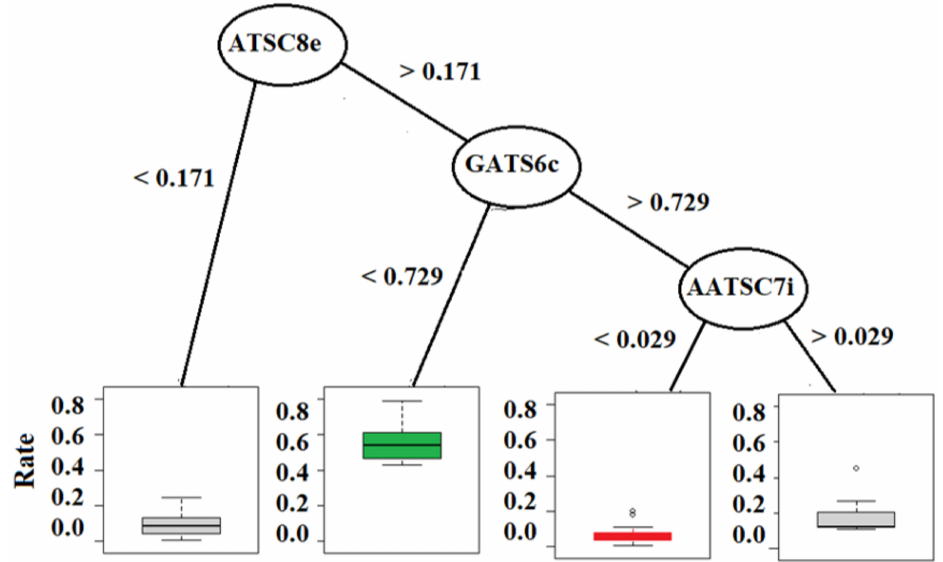
Figure 4. A minimal decision tree for prediction of decolorization. ATSC8e—2D Broto-Moreau auto- correlation of lag 8 (log function) weighted by electronegativity, GATS6c—2D Geary coefficient of lag 6 weighted by Gasteiger charge, AATSC7i—averaged and centered Moreau-bro to the autocorrelation of lag 7 weighted by ionization